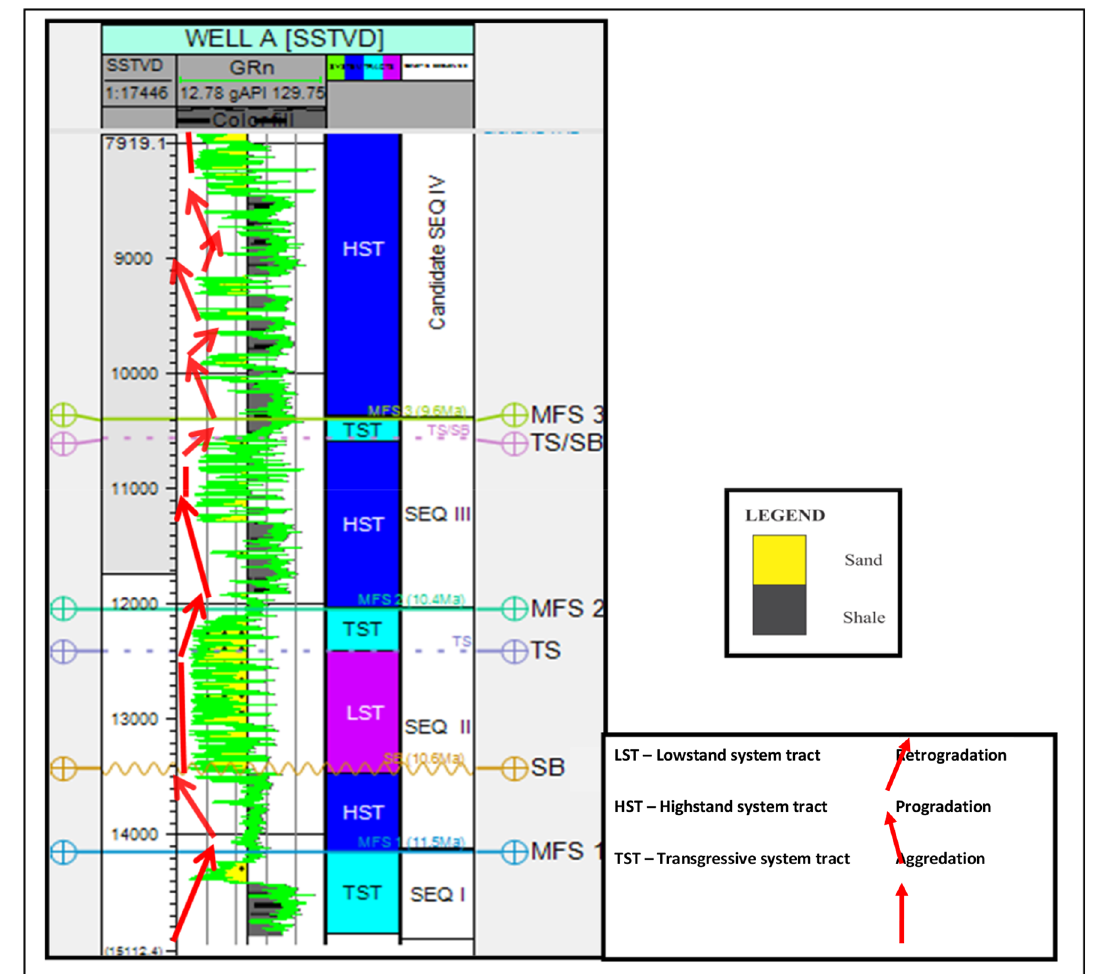
Fig. 9 Wireline log showing system tracts, parasequence sets and genetic